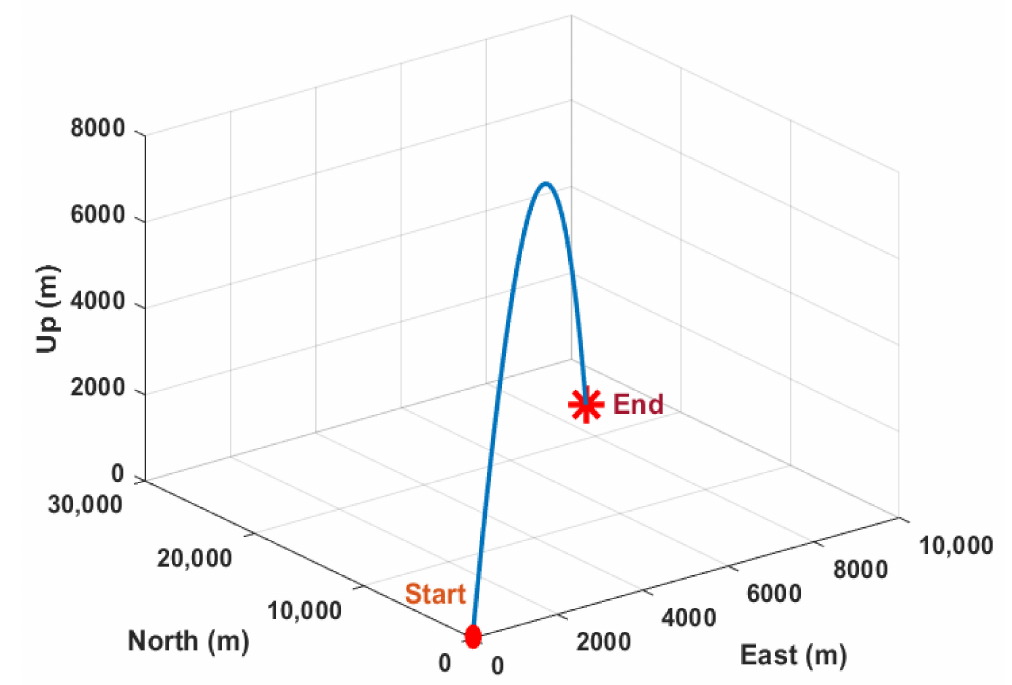
Figure 4. Simulation movement